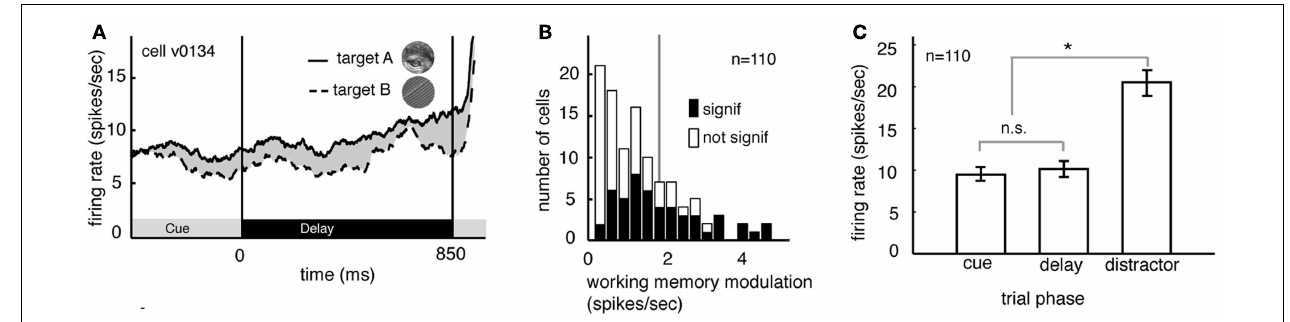
sample of 110V4 neurons. Black bars denote significantly modulated cells. Vertical line indicates the mean modulation in significantly modulated cells. Significant delay modulation is more frequent than would be expected by chance. (C) Bar graph shows the average response of all neurons in our sample during the cue, delay, and early distractor portions of the task, averaged over all trial conditions. Responses during the cue and delay periods of the task are not significantly different.The lack of a visual response supports the idea that neurons are not activated by the cue. Cues do not evoke a sensory response in our